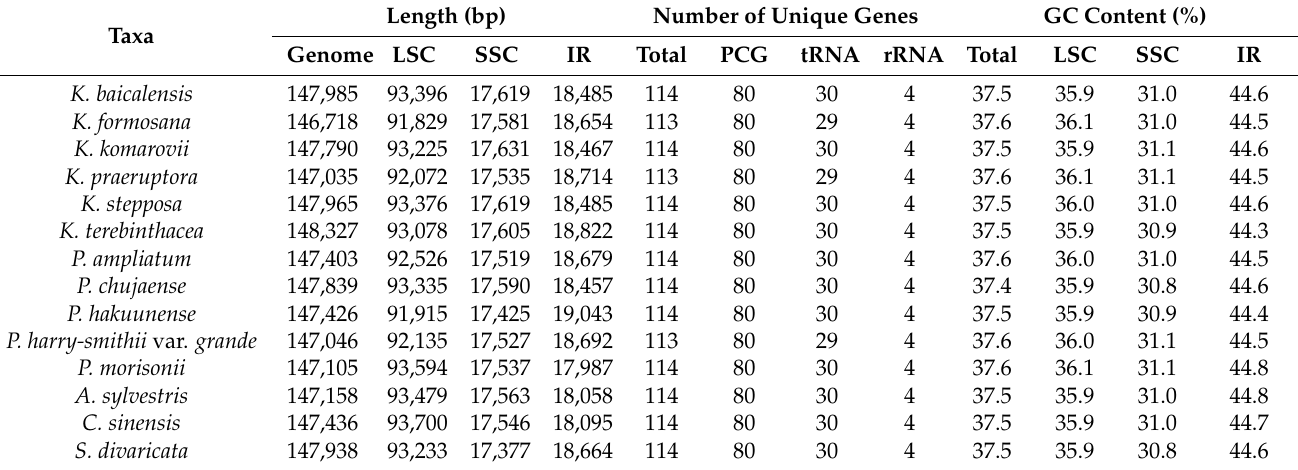
Table 1. Features of the 14 plastid genomes of Kitagawia and related